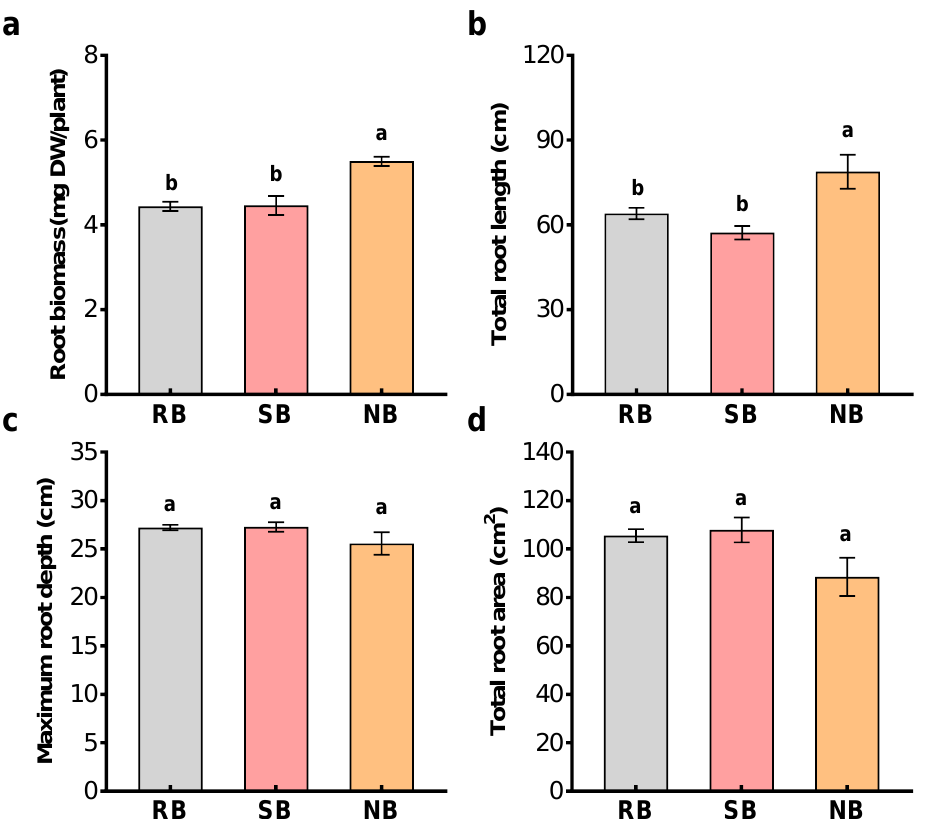
Figure 2. Root biomass ( a ), total root length ( b ), maximum root depth ( c ) and total root area ( d ) of penoxsulam-resistant barnyardgrass ( RB ) in the presence of penoxsulam-susceptible barnyardgrass ( SB ) and normal barnyardgrass ( NB ). Values plotted are means plus/minus SE. Columns with the same letter are not significantly different at p < 0.05 according to ANOVA, followed by Tukey HSD tests.